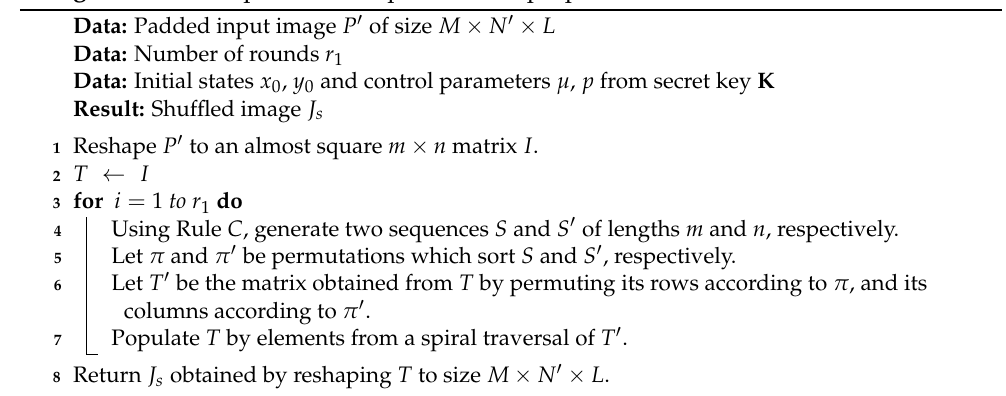
Algorithm 4: The permutation phase of the proposed